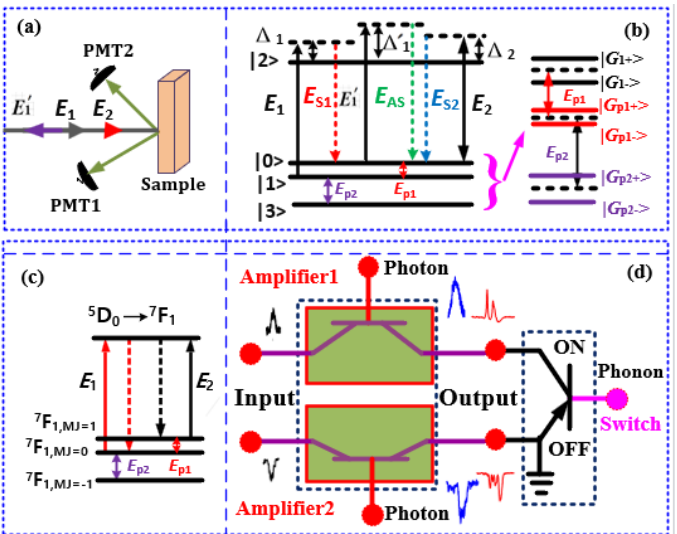
Figure 1. ( a ) Experimental setup, ( b ) Shows photon and phonon four-dressing energy level. ( c ) Shows energy levels of Eu 3+ : BiPO 4 for transition 7 F 1 → 5 D 0 . ( d ) The schematic diagram of proposed optical transistor as an amplifier and switch.